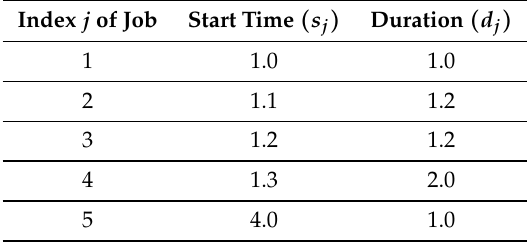
Table 1. An instance of ORP with five jobs. Jobs arrive in the order of their index j